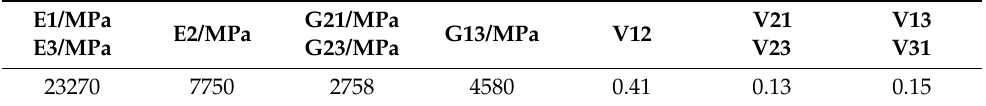
Table 2. The material properties of GFRP; E i : Elastic Modulus (i = 1,2,3); G ij : Shear Modulus (i = 1,2,3;